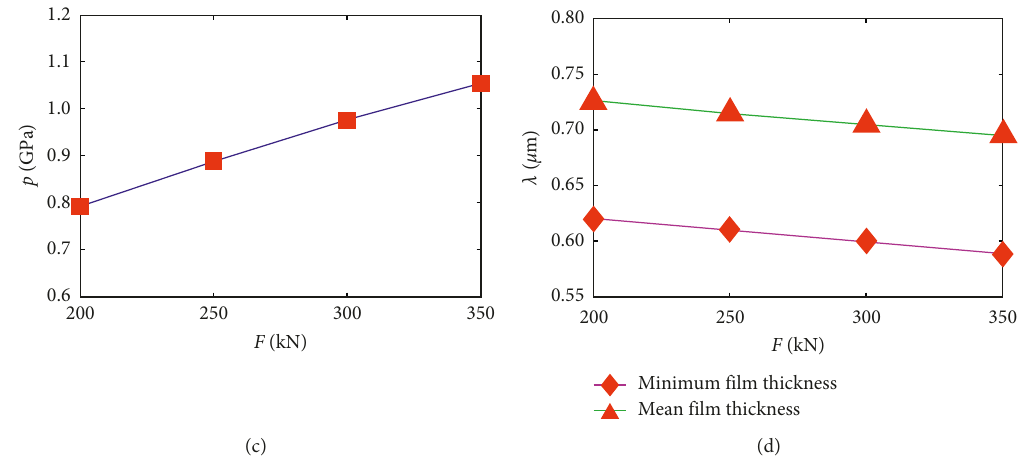
Figure 12: Comparison of lubrication characteristics under different loads: (a) film pressure distribution; (b) film thickness distribution; (c) maximum film pressure; (d) minimum film thickness and mean film thickness.